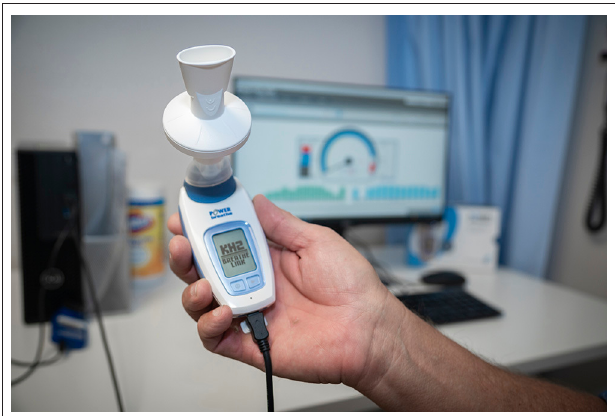
FIGURE 1 | Handheld POWERbreathe training